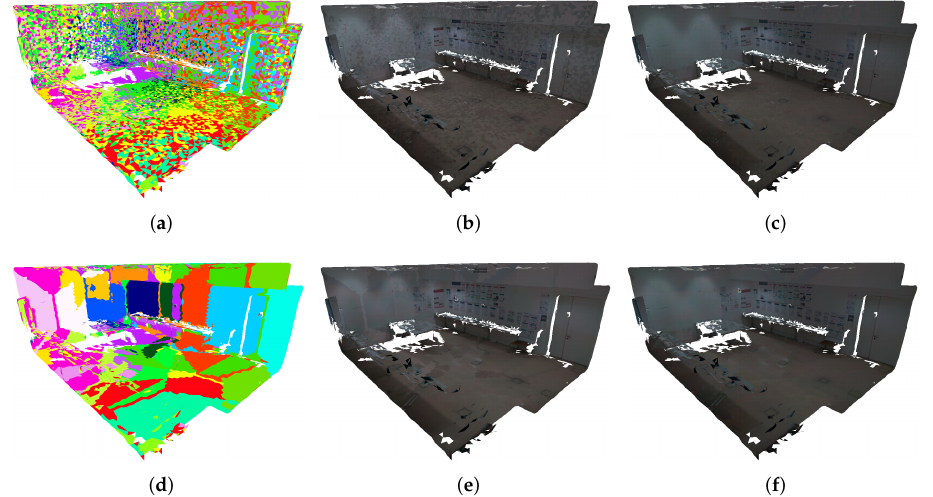
Figure 9. Textured meshes produced by each image selection method. ( a , d ) The result of the random selection and the largest projection area selection methods, respectively. ( b , c ) The resultant textured meshes produced by the random selection criterion using the original images and the color corrected images, respectively. ( e , f ) The resultant textured meshes produced by the largest projection area criterion using the original images and the color corrected images,